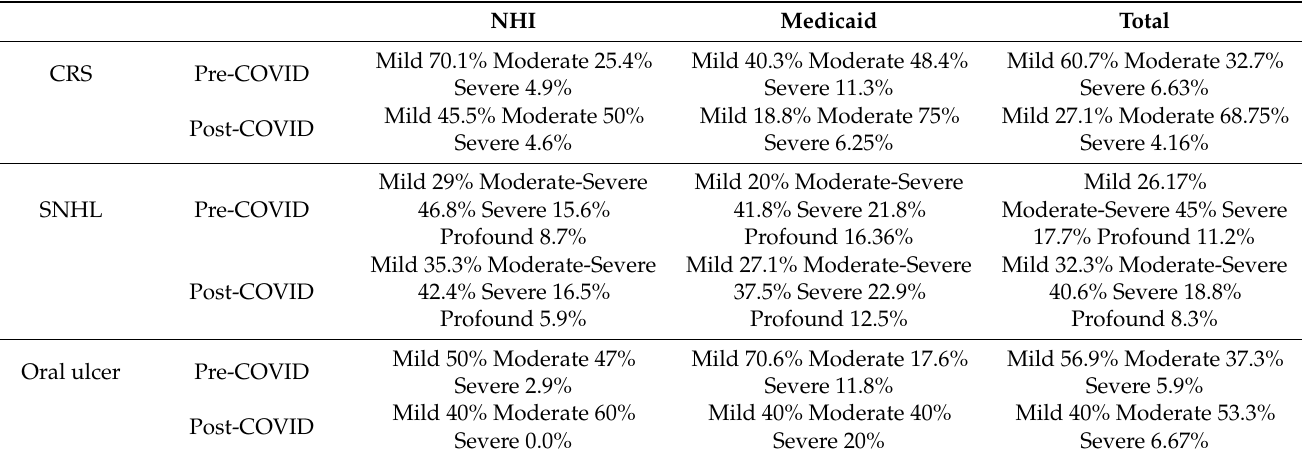
Table 2. Change in the proportion of disease severity during pre- and peri-COVID-19